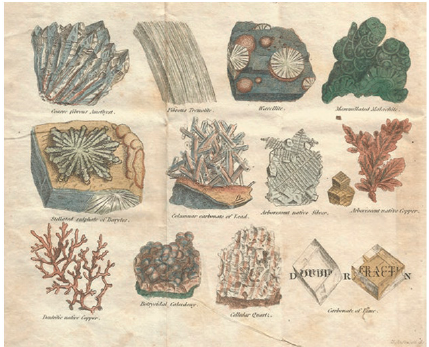
Figure 7. Plate from Varley’s Conversations on Mineralogy [32]. From Larsen, ref. [29].